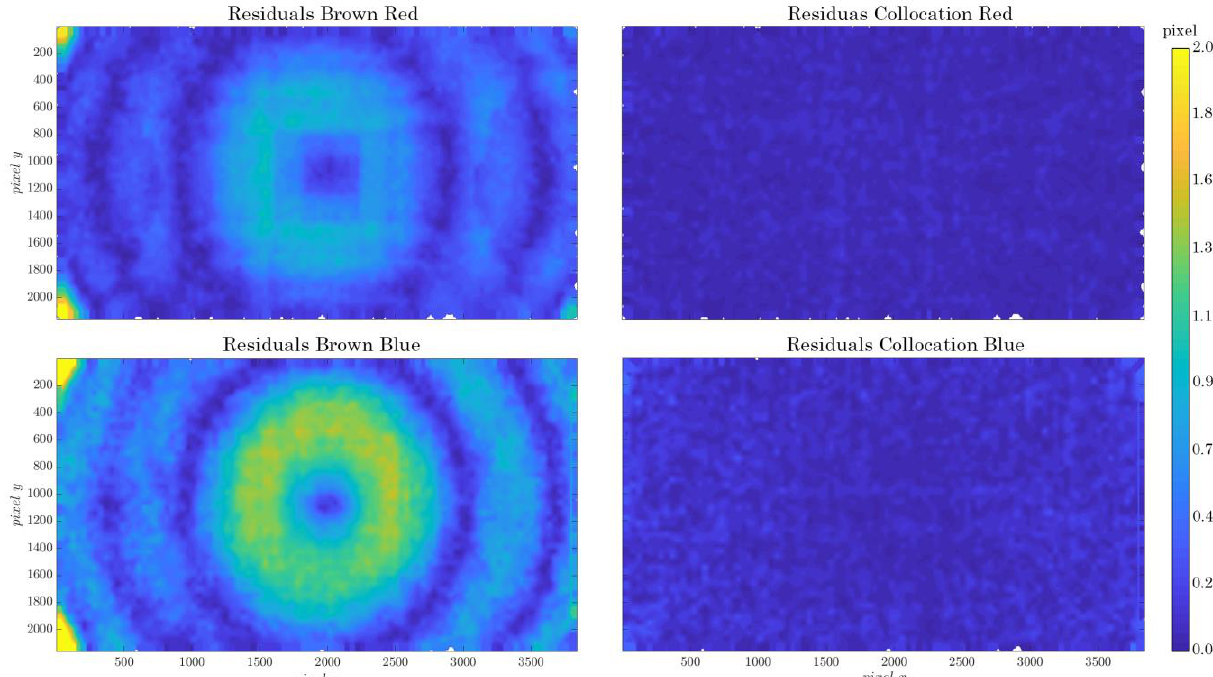
Figure 5. Residual displacement estimates after correcting CA by radial distortion parameters (Brown model) on the left, and with the collocation approach on the right. The top row shows the red channel, the bottom row the blue channel.